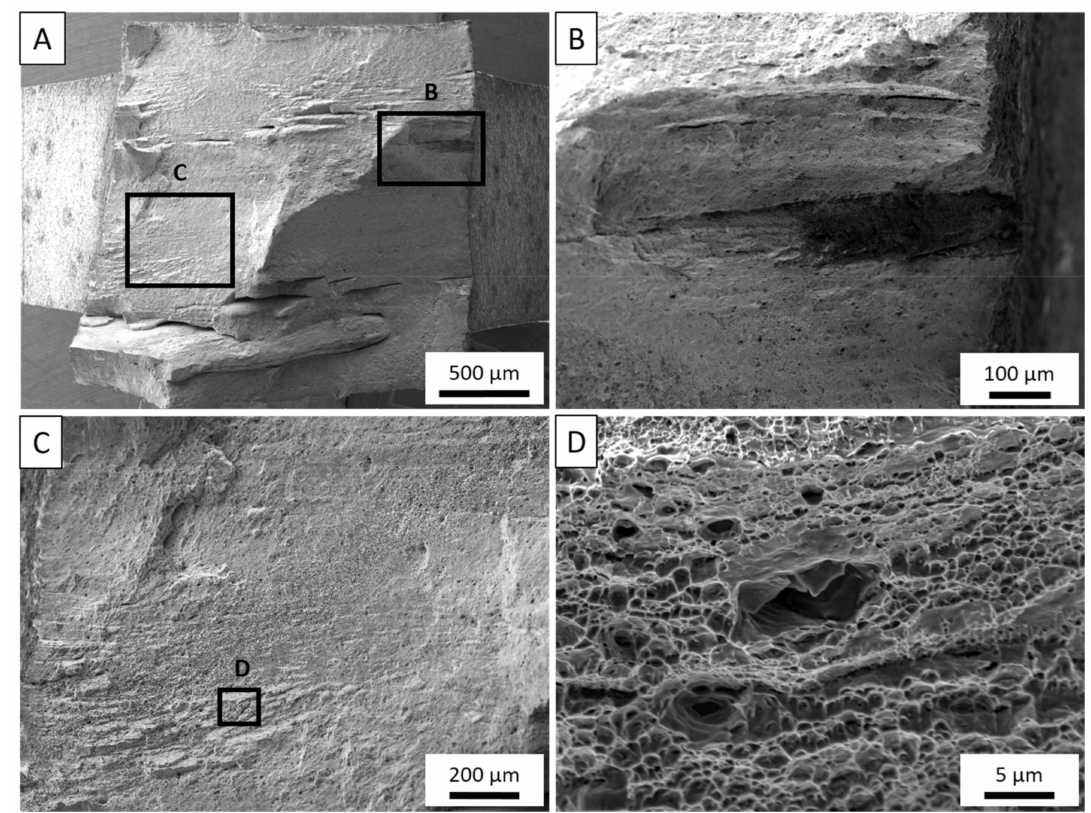
Figure 8. ( A ). Post-mortem analysis of tensile sample tested in the horizontal, longitudinal direction. ( B ) Contamination observed near delamination crack. ( C ) Material flow lines parallel the deposited layers with a larger void encasing a secondary-phase particle. ( D ) Traditional ductile dimpling and larger void encasing a secondary-phase particle